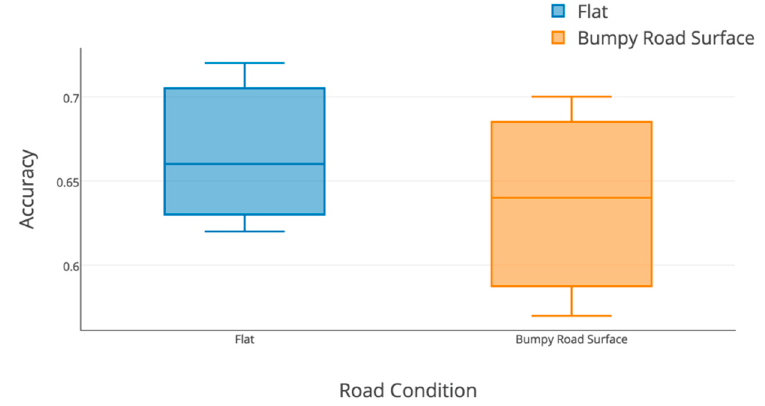
Figure 18. Real-time turning detected accuracy with different road conditions on highway.